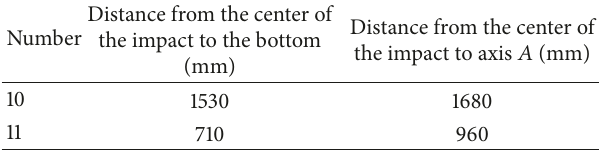
Table 10: Scheme of reinforcement at different impact